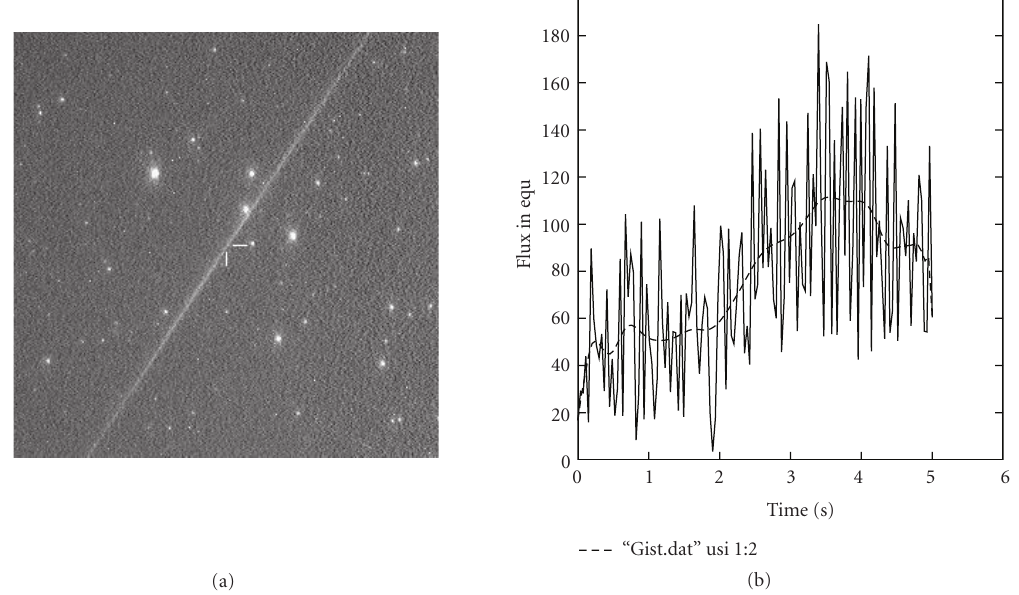
Figure 12: Meteor and its automatically determined brightness profile, FOV is about 5 ◦ × 5 ◦ here.